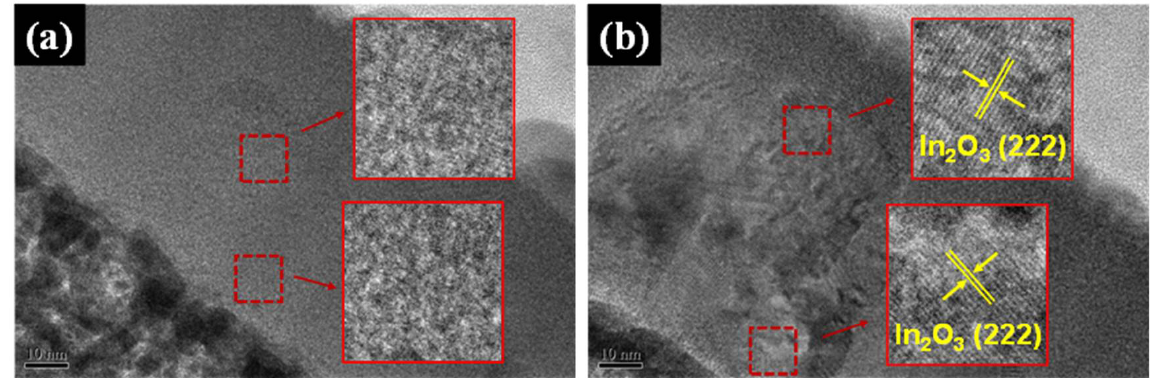
Figure 4. The cross-sectional TEM images as well as the corresponding enlarged images of ITZO films deposited with pulse off-times of ( a ) 0 μs and ( b ) 2000 μs.